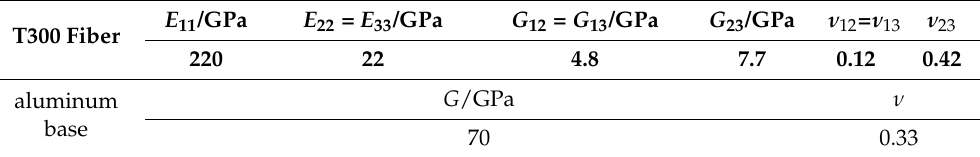
Table 2. The elastic properties of the T300 carbon fiber and aluminum base